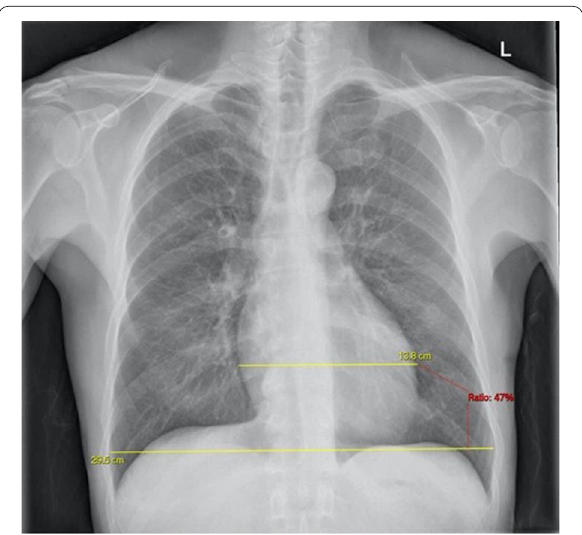
Fig. 2 The cardiothoracic ratio on PA chest radiograph. The maximum transverse cardiac diameter is divided by the maximum transverse diameter of the thorax and multiplied by